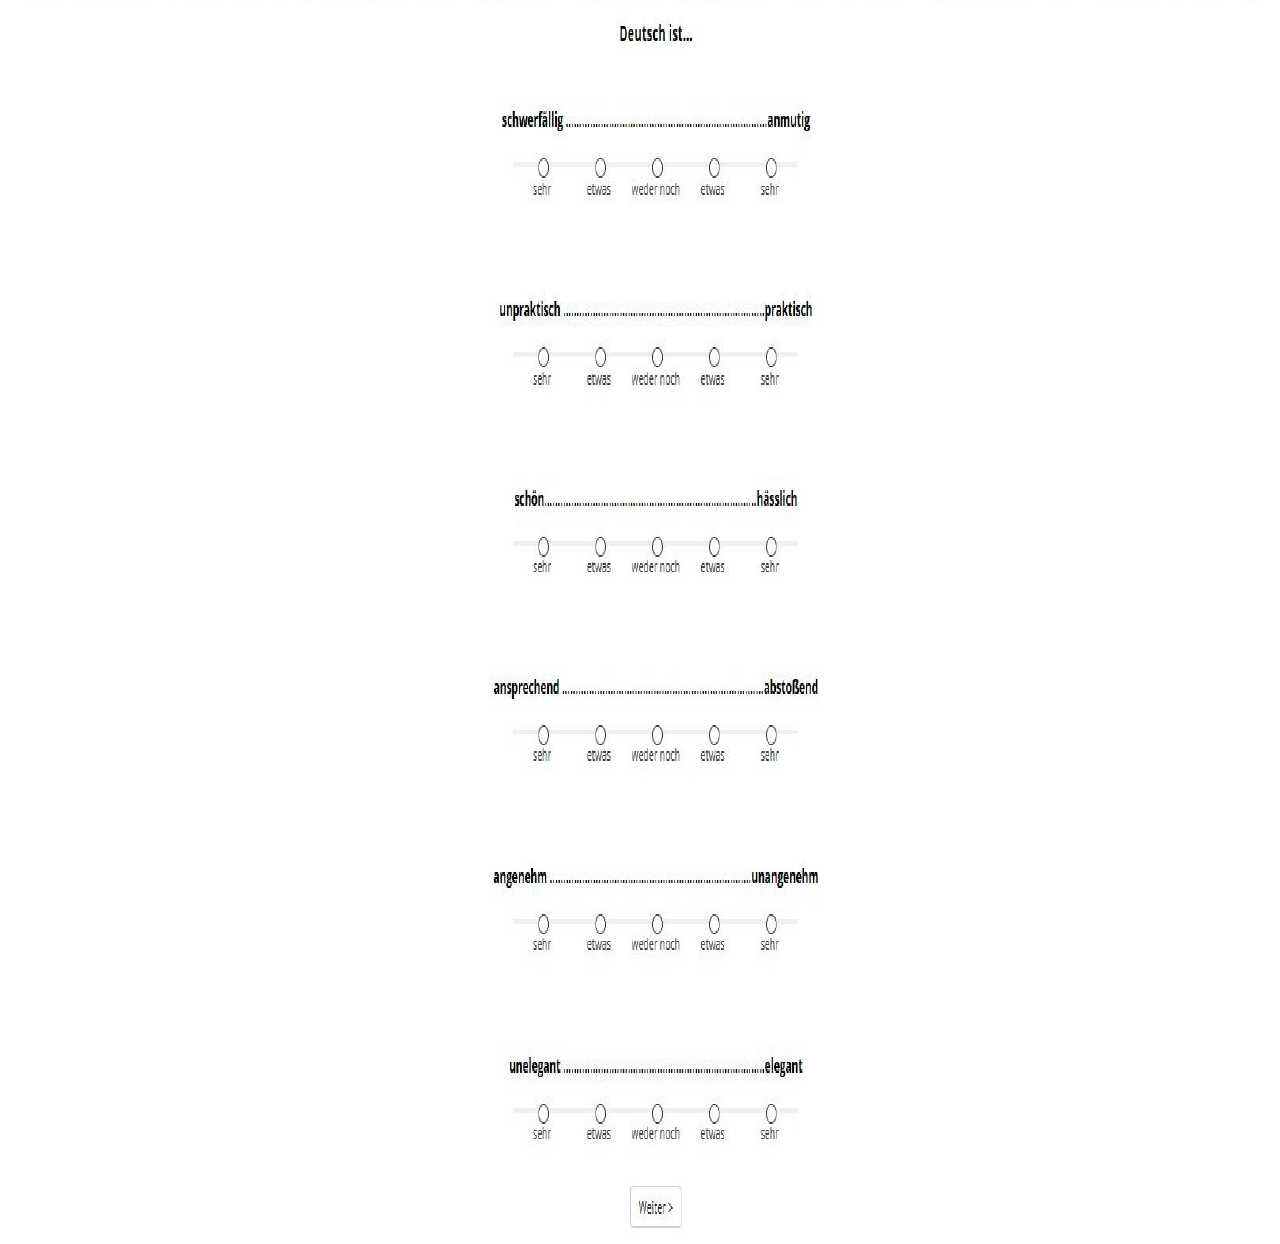
Figure A4. Semantic differential scales to measure attitudes towards German in Belgium and Luxembourg.